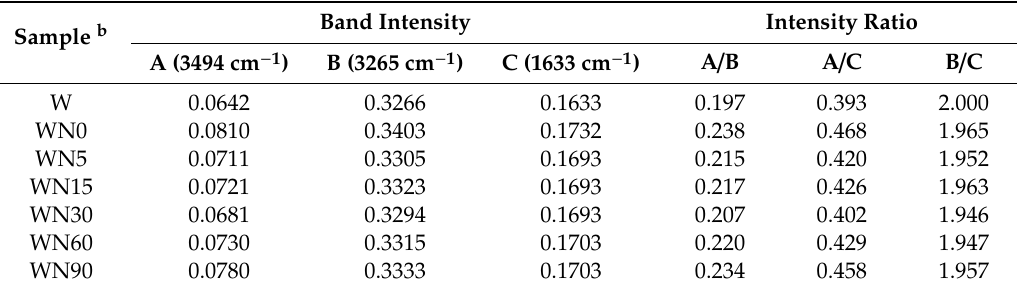
Table 1 for notation.